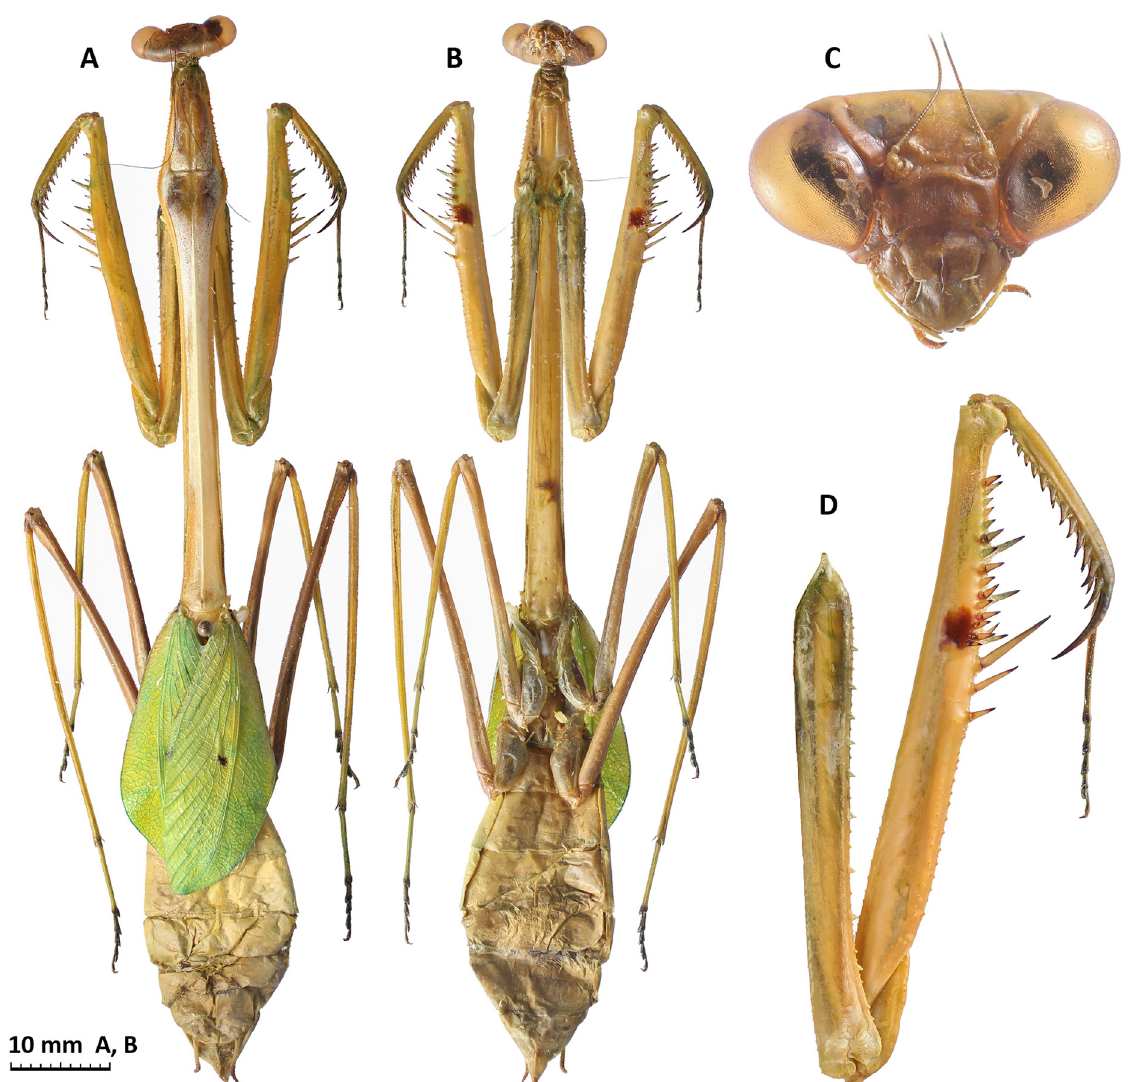
Fig. 3. Phasmomantella nuichuana gen. et sp. nov., holotype, ♀. A . Habitus, dorsal view. B . Habitus, ventral view. C . Head, frontal view. D . Left anterior leg, anterior view. C–D not to